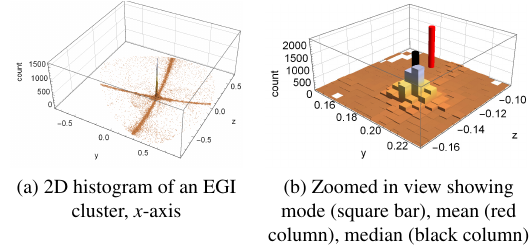
Figure 4. EGI cluster along the x -axis for high quality data set